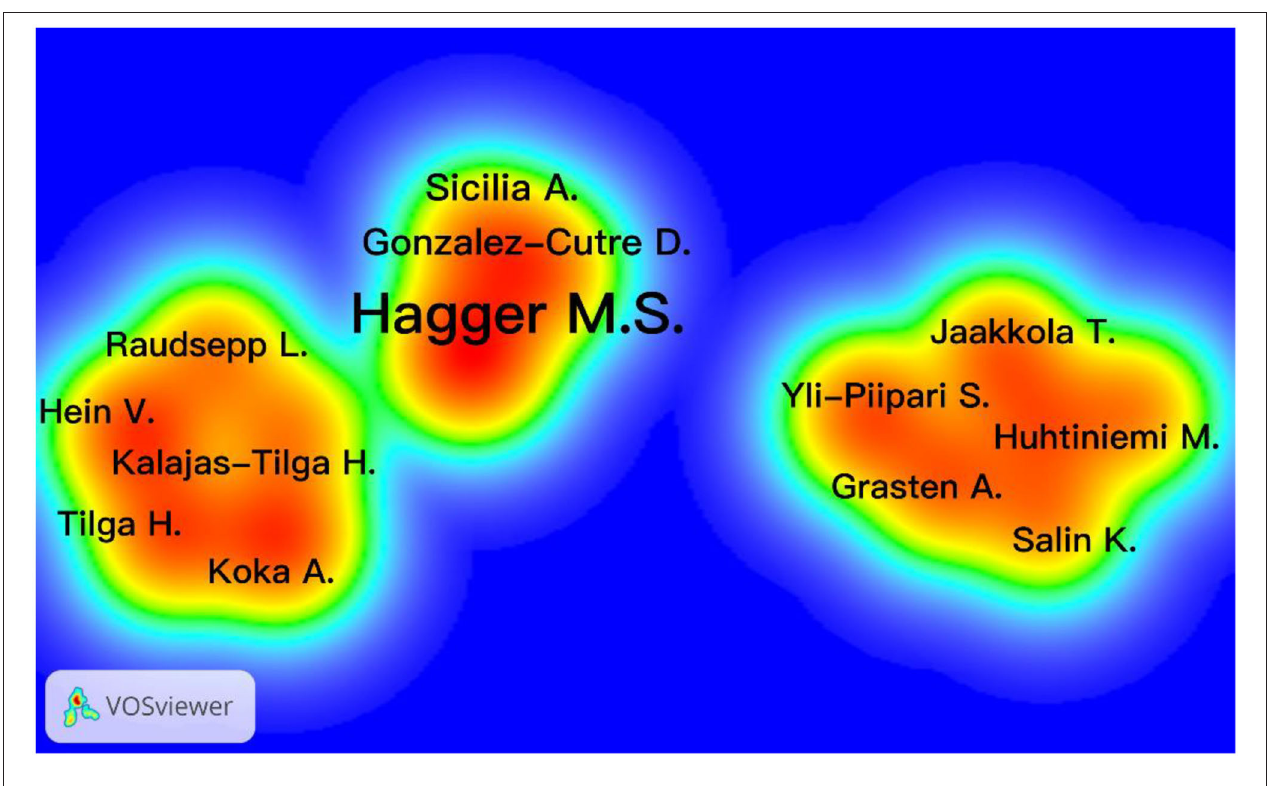
FIGURE 7 | Author’s published density